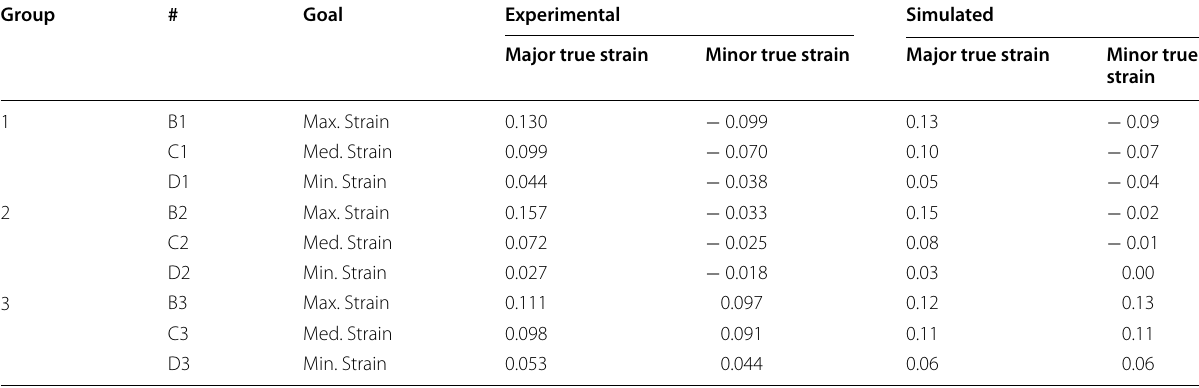
Table 3 Strains in the conventional process.